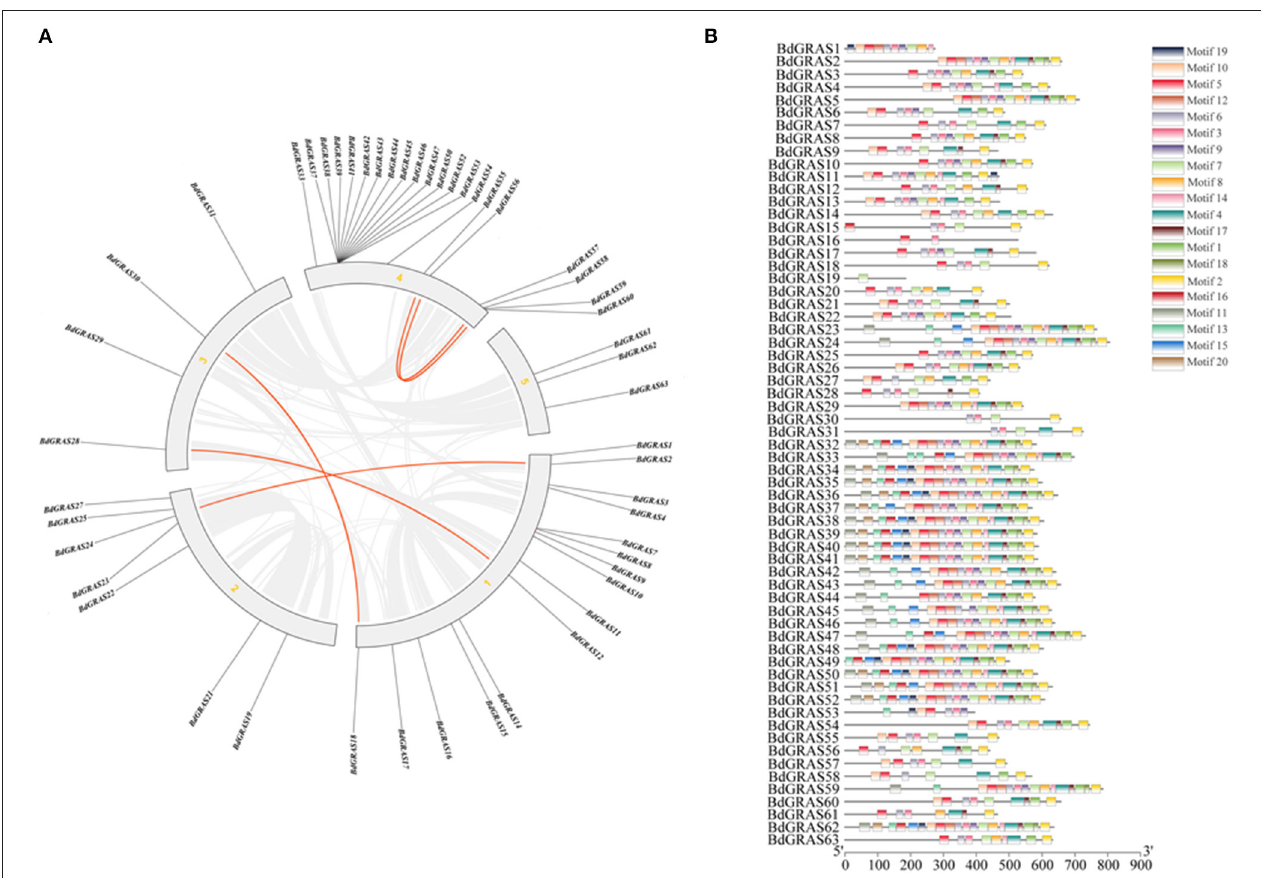
FIGURE 2 | BdGRAS gene replication and conserved domain analysis. (A) Connecting lines indicate duplicated genes where in red lines represent GRAS genes while gray lines signify collinear blocks in whole genome. Composition of the GRAS protein motif of B. distachyon . (B) Identify the BdGRAS protein through the MEME website, and allow up to 20 motifs. Others are the default settings, and 20 different motifs are represented by different colored rectangles.